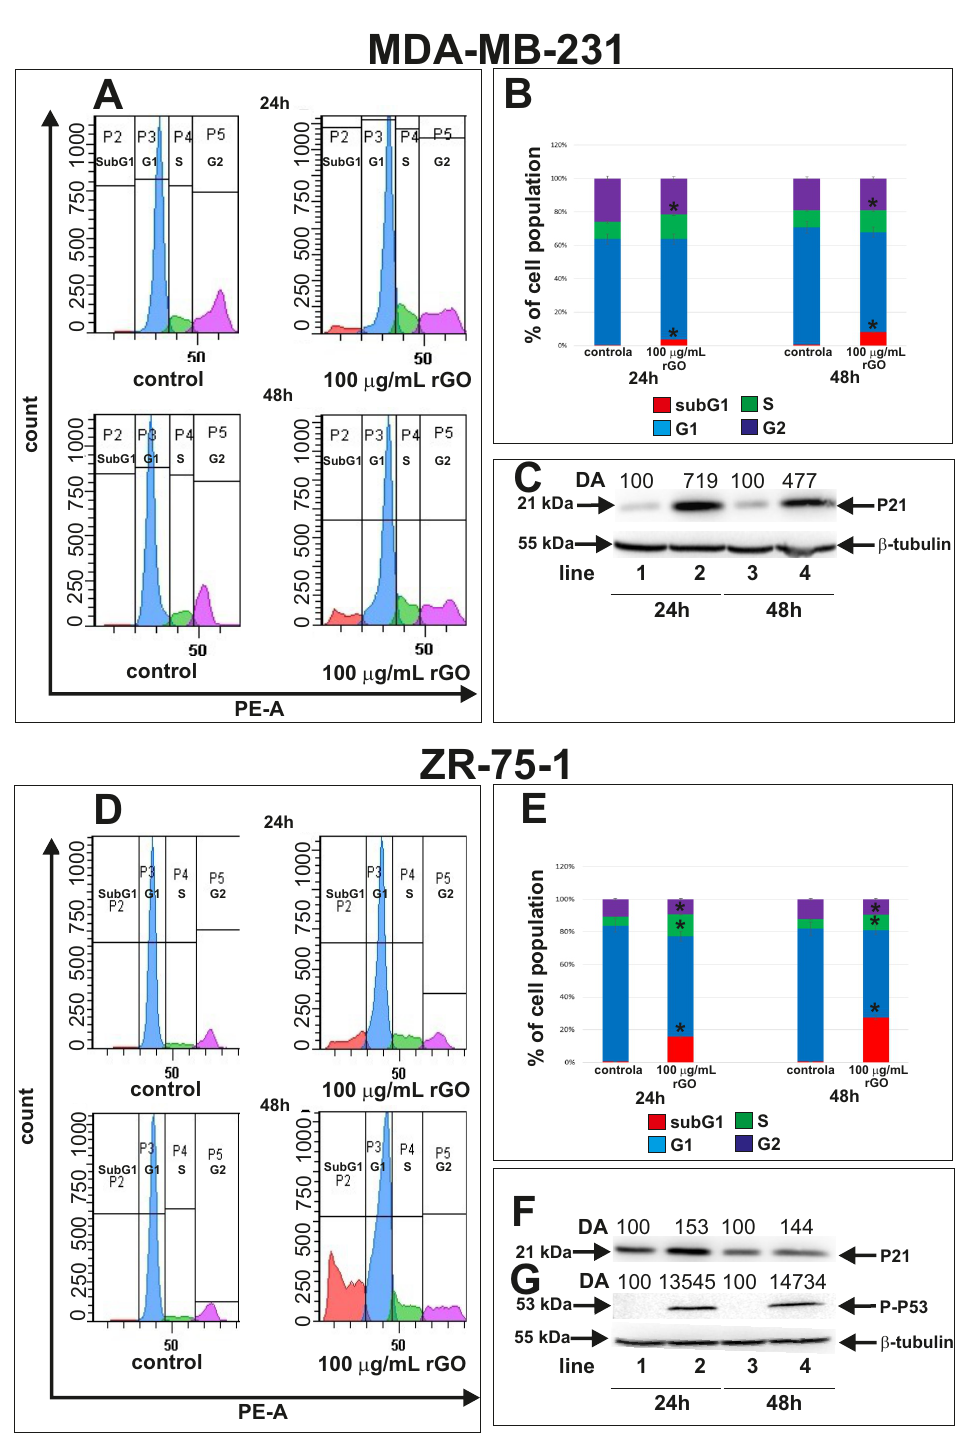
Figure 2. Flow cytometric analysis of MDA-MB-231 ( A ) and ZR-75-1 ( D ) cells treated with 100 µ g/mL of rGO and later stained with propidium iodide. Histogram representation of the cell cycle profiles obtained from flow cytometry measurements ( A , D ) and a bar graph presenting the percentage of cell cycle distribution in MDA-MB-231 ( B ) and ZR-75-1 ( E ) cells. Western blot and densitometric analysis of P21 expression in MDA-MB-231 ( C ) and ZR-75-1 ( F ) and P-P53 expression in ZR-75-1 ( G ) cells incubated with 100 µ g/mL rGO for 24 and 48 h. Samples containing 15 µ g of protein were submitted to electrophoresis and immunoblotting. Densitometric analysis (DA) was presented as a relative fold change in comparison to untreated controls, expression level of which was set as 100. The expression of β -tubulin served as a control for protein loading. Mean values of flow cytometry analysis from three independent experiments ± SD are presented. * p <